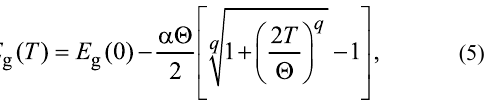
Sample Component